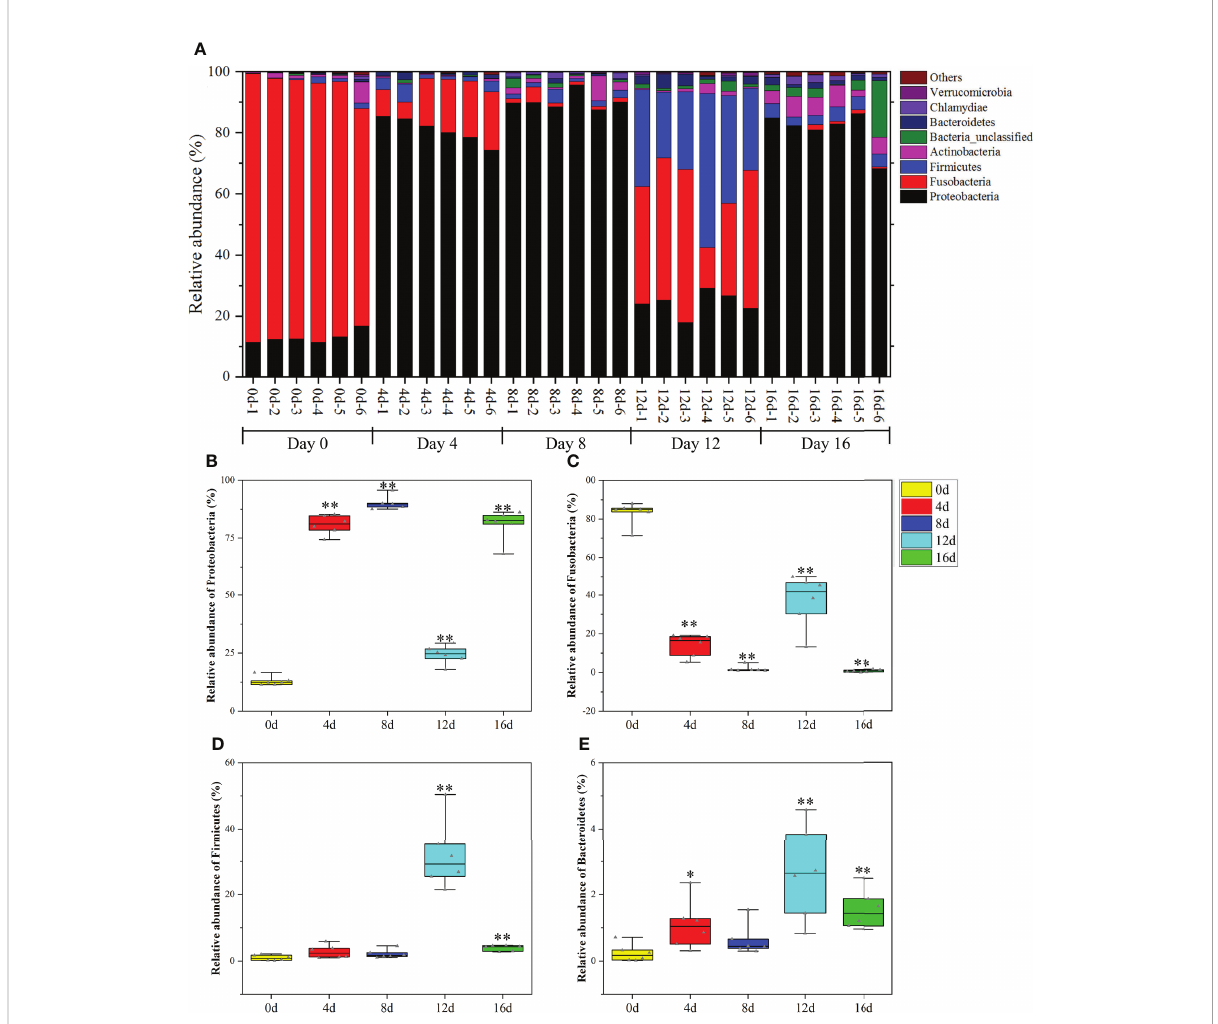
FIGURE 5 The in fl uences of short-term exercise on microbial phyla in this hybrid species. Relative richness of dominant microbial phyla in the intestine of this hybrid species under different durations of swimming exercise (A) . Abundance differences in Proteobacteria (B) , Fusobacteria (C) , Firmicutes (D) , and Bacteroidetes (E) among different durations of swimming exercise groups at the phylum level. * P ≤ 0.05, ** P ≤ 0.01. Data were provided as mean ±